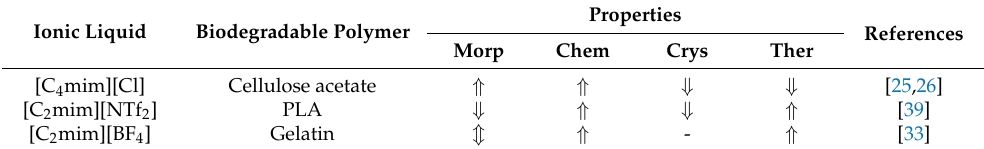
Table 8. Properties of electrospun biodegradable polymer fibers assisted by ionic liquids as additives. Ionic Liquid